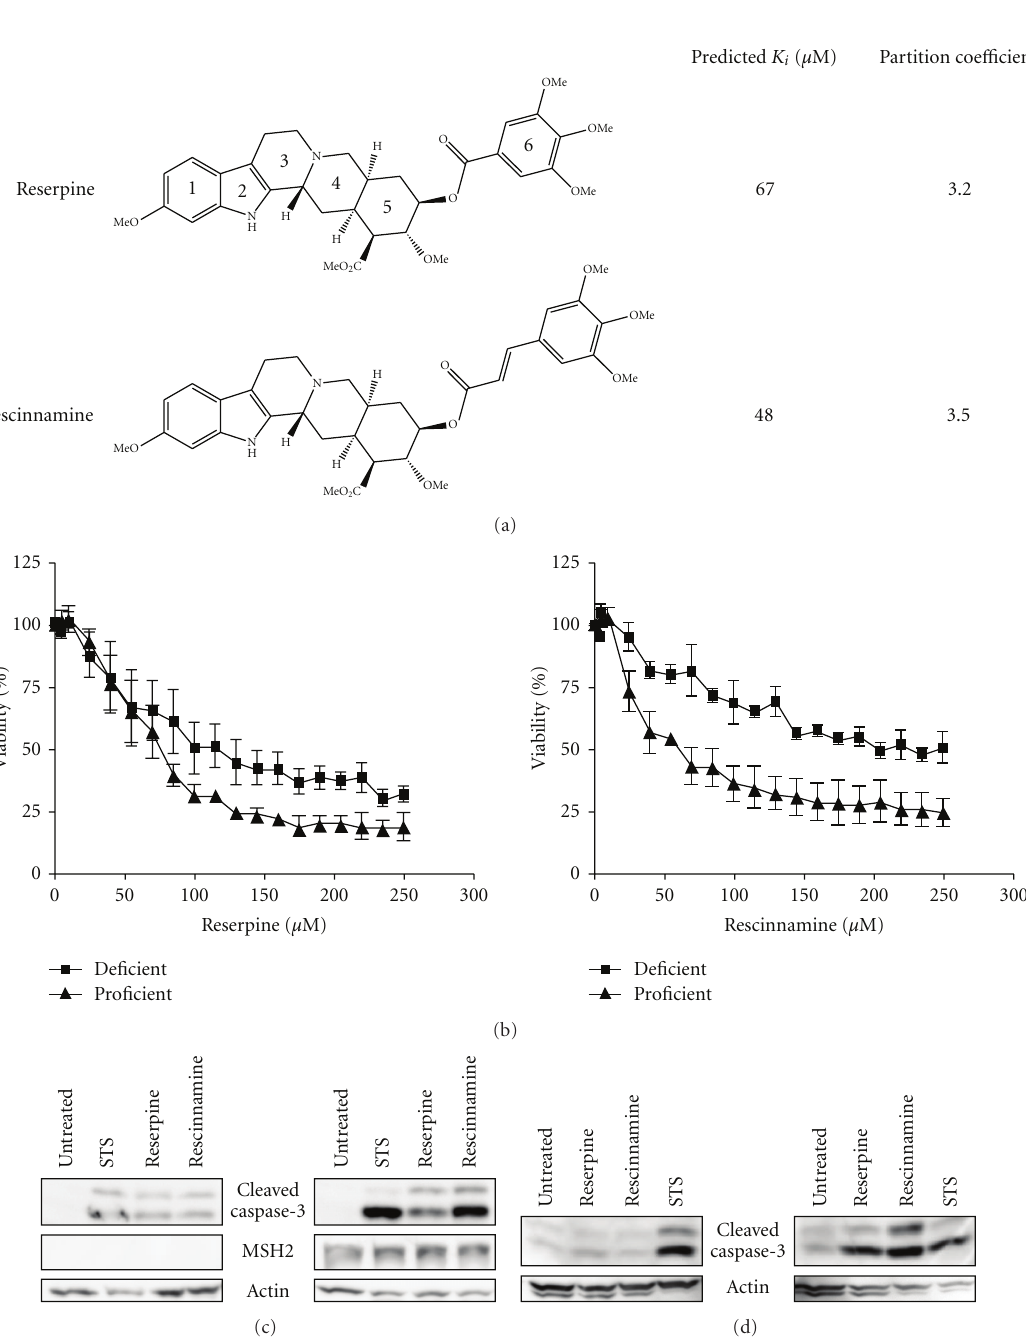
Figure 1: (a) Structures of reserpine and rescinnamine with their binding constants and calculated partition coe ffi cients (see Methods for details). (b) MTS cell survival assay shows MSH2-dependent cell viability after concentration-dependent reserpine (left) and rescinnamine (right) treatments. MSH2-deficient cell response is shown with squares, proficient response with triangles. (c) Western blot shows caspase-3 cleavage in Hec59 ( MSH2 -deficient; left panel) and Hec59(2) ( MSH2 -proficient; right panel) cells upon treatment with reserpine (85 µ M) and rescinnamine (60 µ M). The 17 and 19 kDa cleavage products of caspase-3 are depicted. Staurosporine (STS) was used as a positive control; actin was used as a loading control. (d) Western blot displays caspase-3 cleavage in DLD1 ( MSH6 -deficient; left panel) and DLD1(2) ( MSH6 -proficient; right panel) cells treated with reserpine and